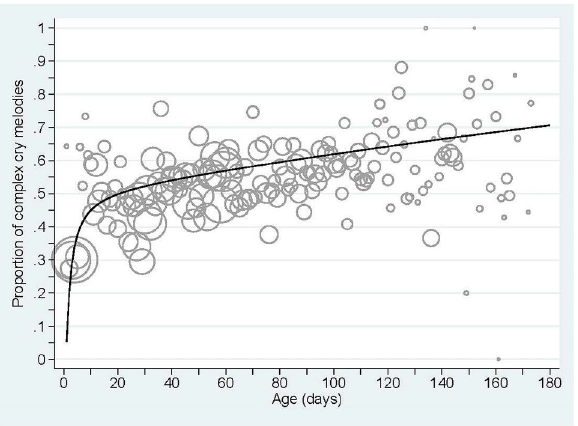
Figure 2. Bubble plot of the proportion of complex melodies in cries over age together with the mean prediction line derived from the final multi-level mixed effects logistic regression model. Note: the bubble size gives the relative number. Here, the median bubble size represented n = 197, with Q1 = 88, Q3 = 331 and range: